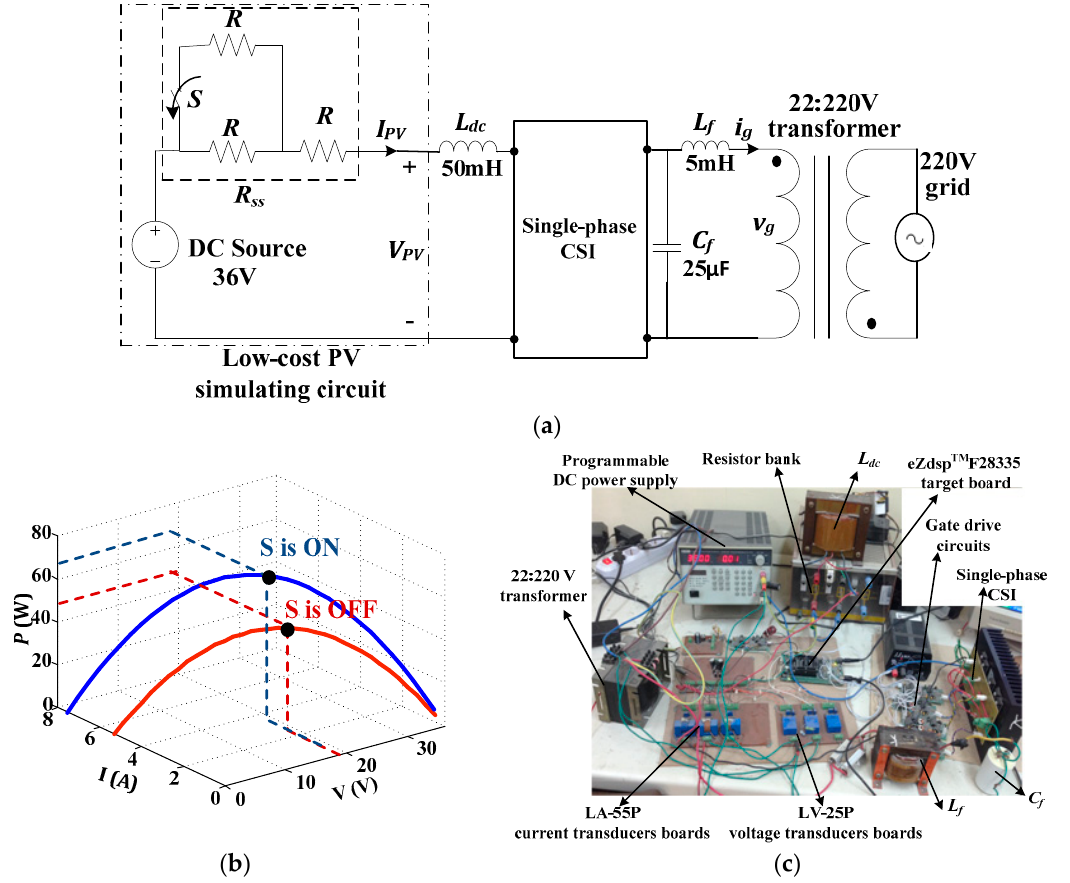
Figure 5. Experimental setup ( a ) schematic diagram, ( b ) P-V, I-V curves of PV emulator under two power levels ( c ) test rig photography. power levels ( c ) test rig